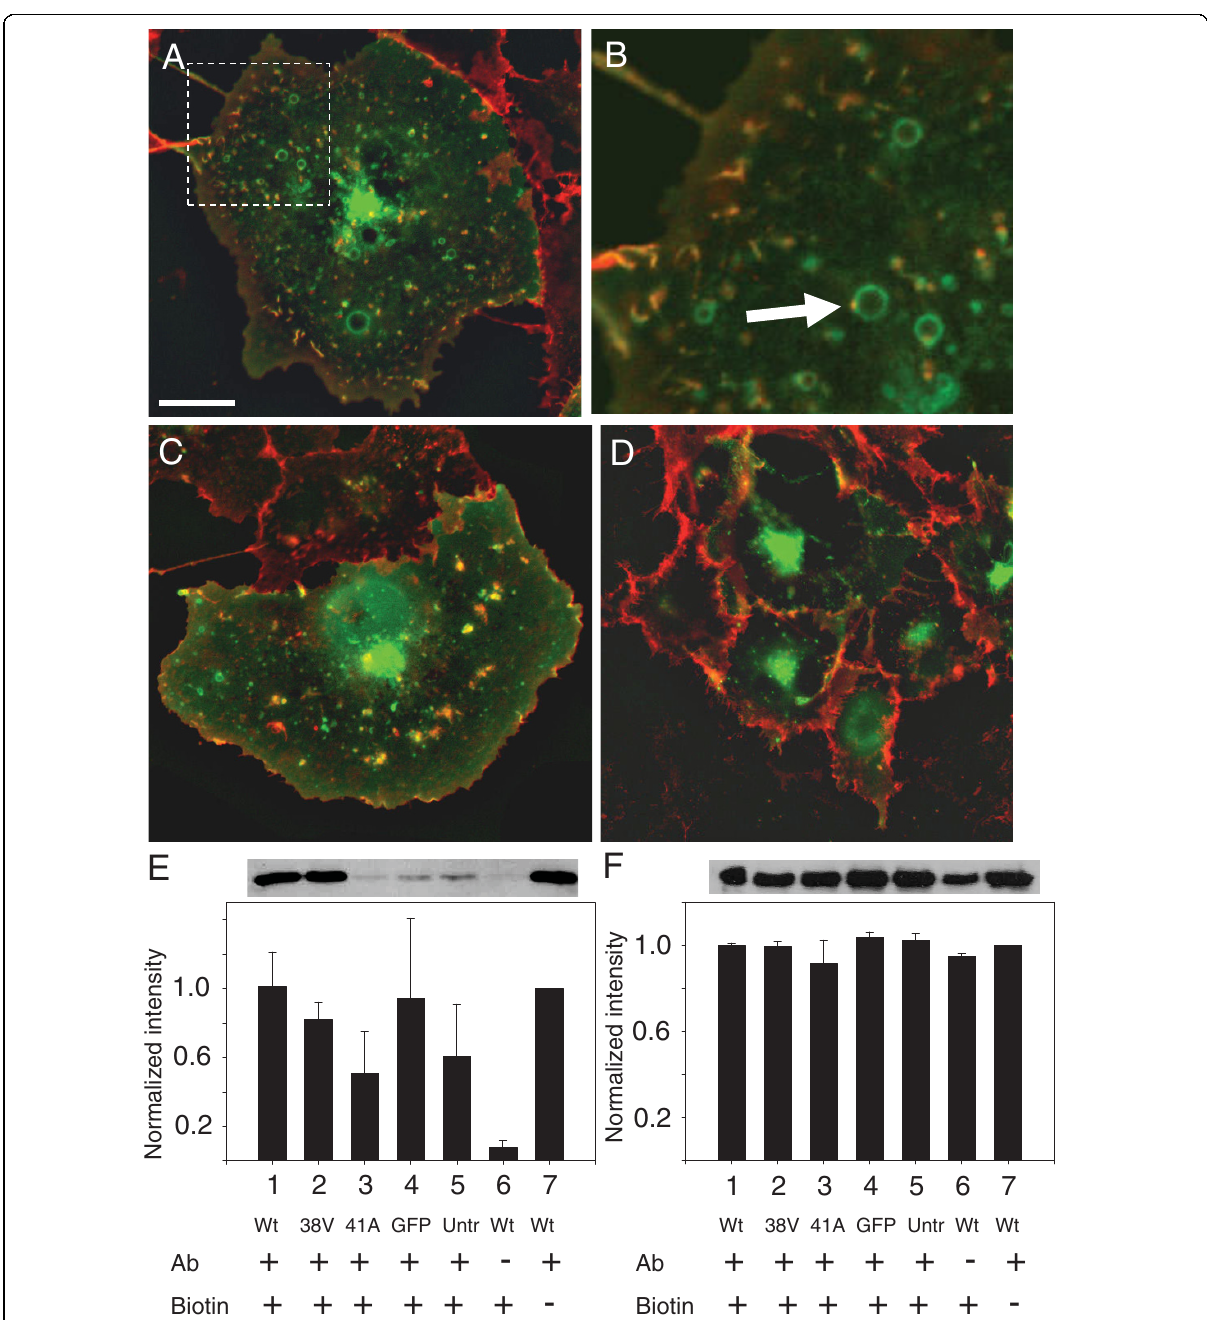
Figure 5 b 1 -integrin is endocytosed from ruffles in an R-Ras dependent manner . Alexa Fluor555 (red)-labeled b 1 -integrin antibody was applied to live Cos7 cells expressing: (A-B) GFP-R-Ras-(wt), (C) -(38V), or (D) -(41A). There was significant overlap between b 1 -integrin and R-Ras (yellow) at ruffles and in vesicles in GFP-R-Ras(wt) and GFP-R-Ras(38V) cells, which was absent in GFP-R-Ras(41A) cells. Note the uniform distribution of b 1 -integrin in cells expressing GFP-R-Ras(41A) (D) . Scale bar is 20 μ m. (E-F) Cells were transfected with the following constructs; lanes 1, 6, and 7- GFP-R-Ras(wt), lane 2- GFP-R-Ras(38V); lane 3- GFP-R-Ras(41A), lane 4- GFP, lane 5- untransfected. Following a 30 min incubation with b 1 -integrin antibody (with the exception of lane 6 as a control, where cells were exposed to antibody for <1 min), cells were biotinylated (with the exception of lane 7, as a control), washed, then lysed and cleared of the biotinylated antibody using strep-avidin beads. The presence of any remaining antibody would be a result of endocytosis during the incubation period, and was quantified by western blot. Densitometry of bands was normalized to lane 7 (wt with no biotinylation) and averaged data (± SEM) from three separate experiments is shown in E. Panel F is data from two experiments where whole cell lysate was probed for b 1 -integrin as a loading control. Exemplar blots are shown above the bar